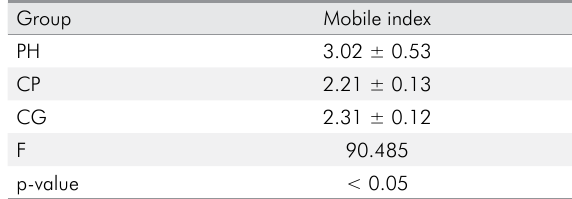
Table 8. Neutrophil movement index results.